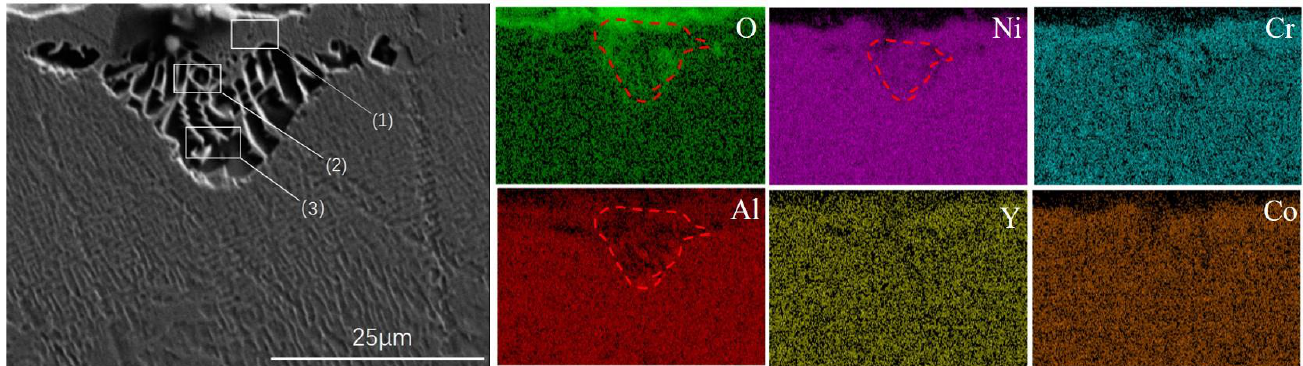
Figure 7. Microstructures and EDS results of a cellular recrystallized structure formed by exposure to high temperatures. (1) there is no columnar γ′ precipitates existing; (2) columnar γ′ precipitates is short; (3) columnar γ′ precipitates are long.